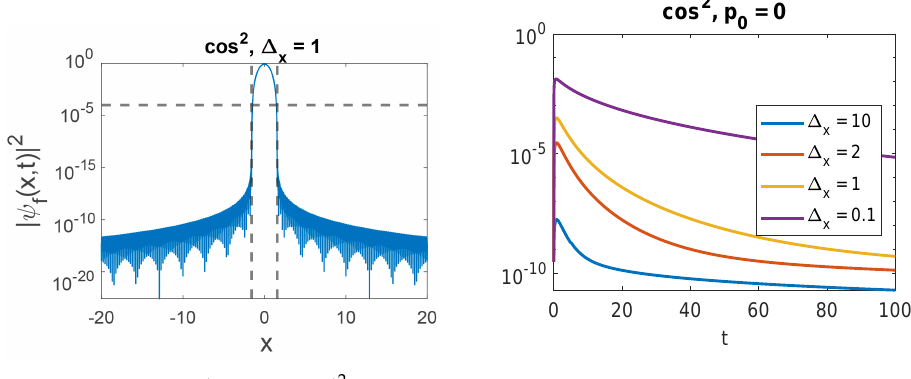
(cid:12) (cid:12) 2 (cid:12) (cid:12) ( t = 0, x ) Figure 4. Left panel: is plotted in logarithmic scale for the function with compact (cid:12) ψ f (cid:12) support f ( x ) = cos 2 ( x / ∆ x ) (with ∆ x = 1 and p 0 = 0). Right panel: fraction of the probability density leaking outside the light cone as this initial wavepacket evolves (each curve shows the result for a different width ∆ x ).